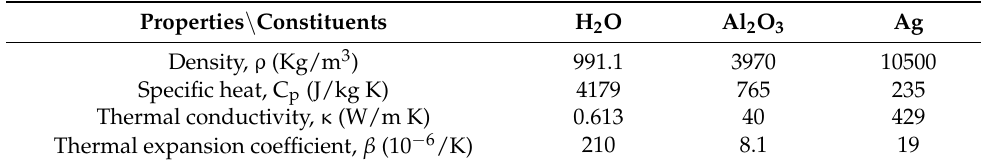
Table 2. The experimental values of the thermophysical properties for the base fluid and nanomateri- als